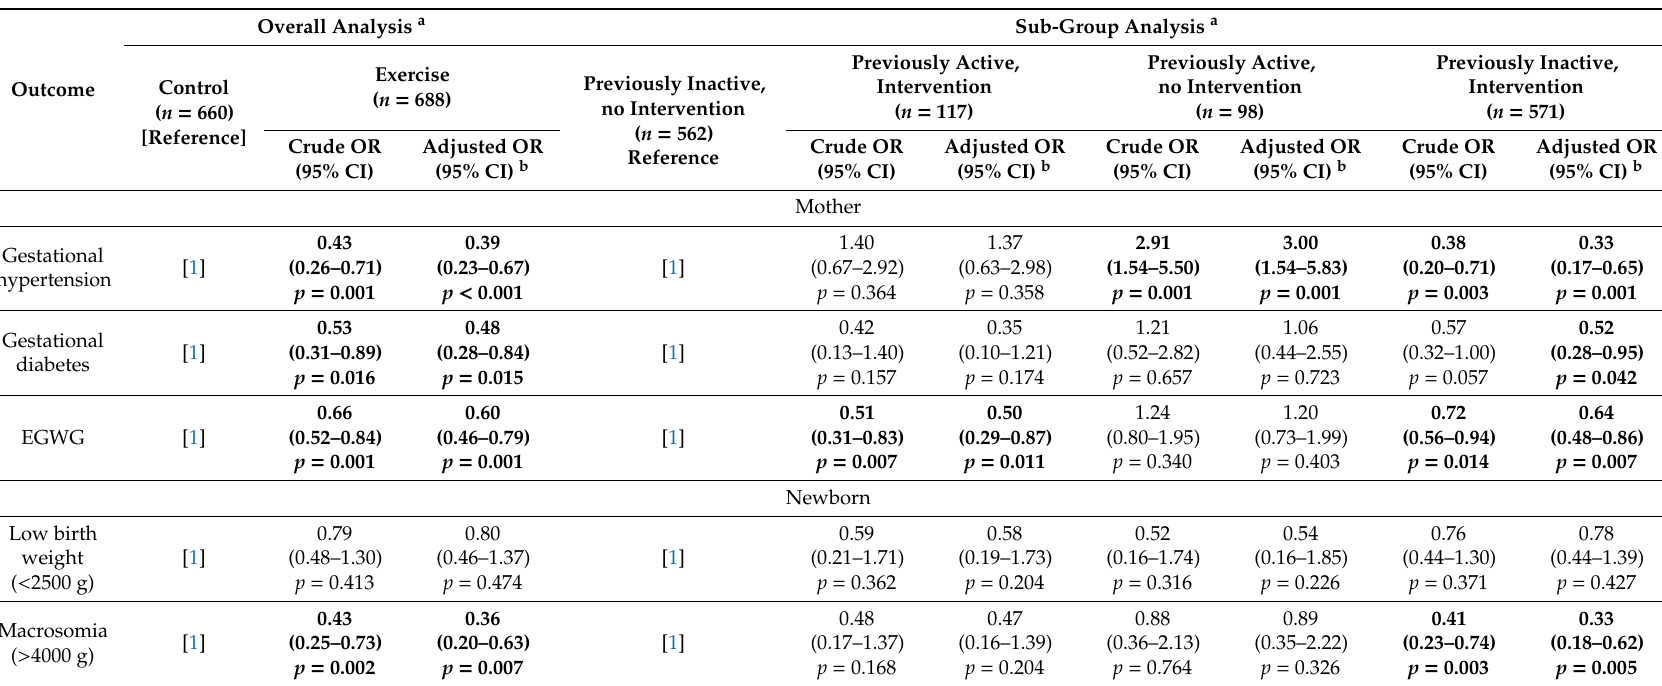
Table 3. Association of pre-pregnancy and pregnancy exercise with study outcomes up to